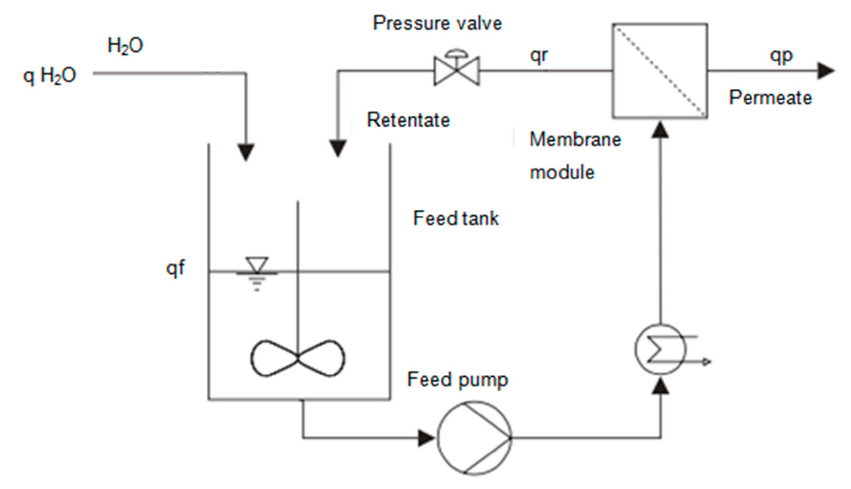
Figure 2. Scheme of a discontinuous operation with full recycle of retentate (adapted from [15]) .